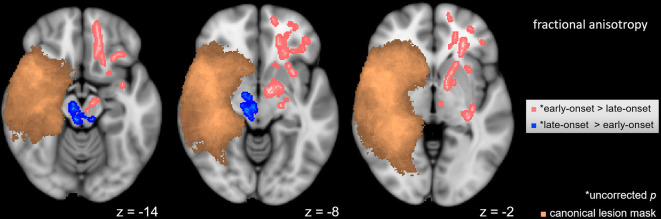
Intragroup FA differences. Voxel-wise t-test in FA between hemispherotomy subgroups with early-onset and late-onset pathologies (p < 0.05, uncorrected for multiple comparisons). Copper voxels indicate a canonical lesion mask. z indicates axial coordinate in MNI space. Skeletonized results were thickened for visualization purposes.